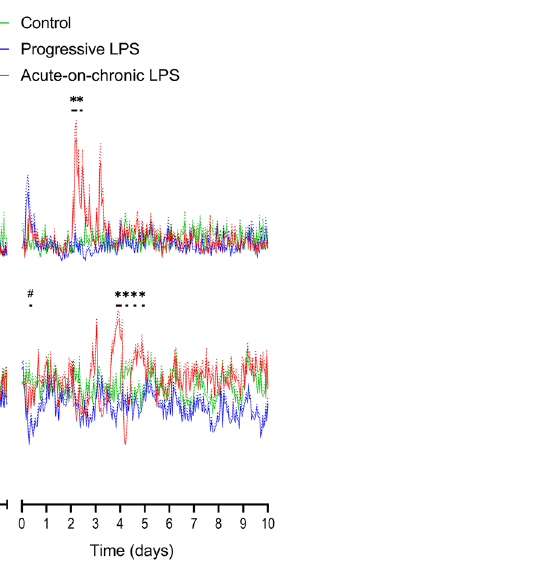
Figure 4. Changes in sample entropy and sample asymmetry during and after LPS infusions. All LPS infusions were started on day 0 and continued for a total of 5 days, fetuses were studied for a further 5 days after the end of infusions. Please note that sample entropy and sample asymmetry are not related indices and are grouped together for convenience. Groups shown are control (green, n = 10), progressive LPS (blue, n = 8) and acute-on- chronic LPS (red, n = 9). Data are shown as 1 h mean ± SEM (mean is displayed as solid lines, SEM is displayed as dotted lines). *P < 0.05 control vs. acute-on-chronic LPS, # P < 0.05 control versus progressive